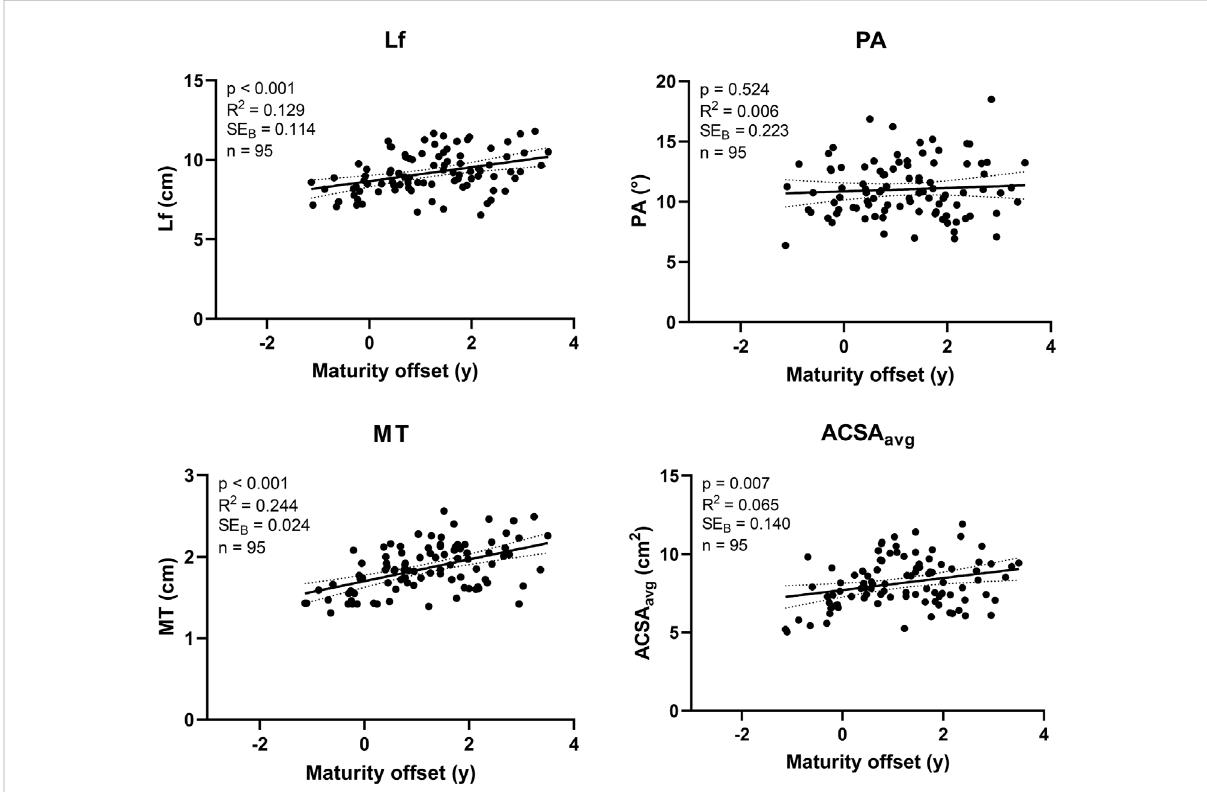
FIGURE 2 Linear regression analyses assessing the association of variables related to biceps femoris long head morphology with biological maturation (i.e., the maturity offset) in competitive alpine skiers around the growth spurt (i.e., U16 skiers). Lf: fascicle length; PA: pennation angle; MT: muscle thickness; ACSA avg : average anatomical cross-sectional